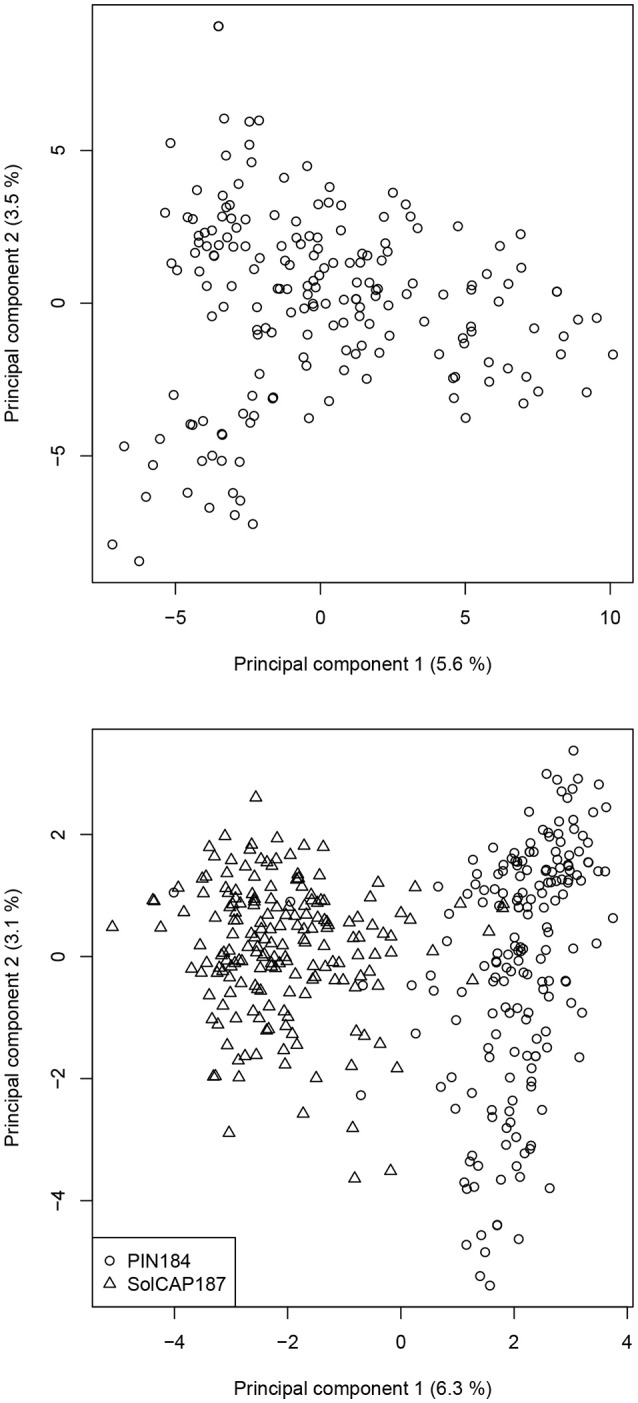
Principal component (PC) analysis based on the polymorphic SolCAP SNPs for the PIN184 population (upper) and the PIN184 and SolCAP187 populations together (lower). Numbers in parentheses refer to the proportion of variance explained by the PC.